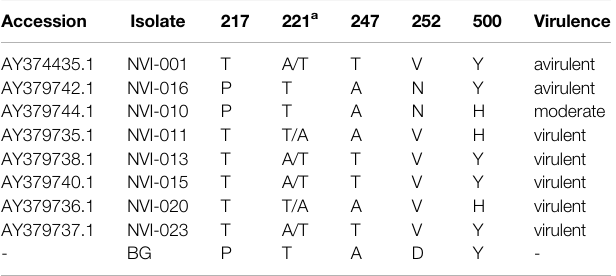
TABLE1| AminoacidsequencesinsegmentAofthenewlyidenti fi edIPNVvariant compared with previously reported key residues, suggested to be in association with the viral virulence (Santi et al., 2004).